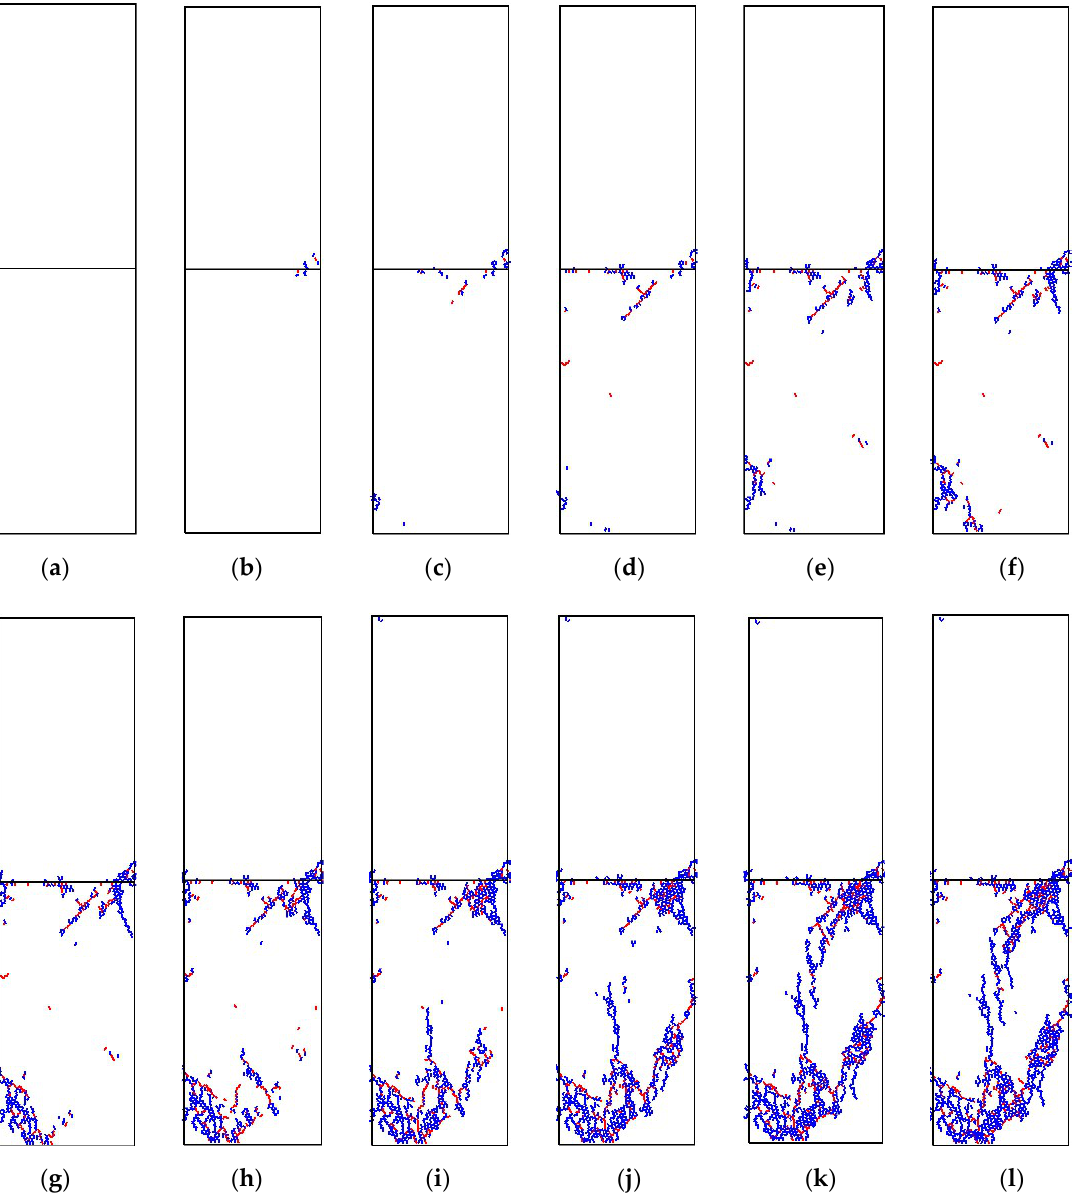
Figure 14. Evolution of crack form and location of serial coal pillar specimens. ( a ) 0; ( b ) 15,000; ( c ) 18,000; ( d ) 20,400; ( e ) 20,800; ( f ) 21,200; ( g ) 21,600; ( h ) 22,000; ( i ) 22,400; ( j ) 22,800; ( k ) 23,200; ( l ) 23,487.